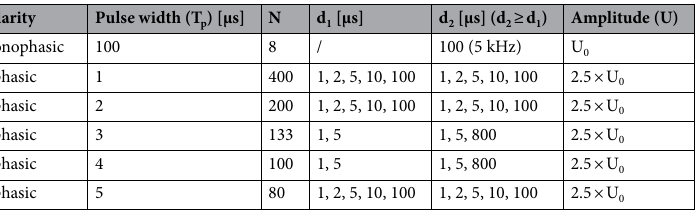
Table 1. Values of the pulse parameters for all pulse protocols included in the study. All biphasic pulse protocols have equal total on-time, i.e., N × 2Tp = 800 µs. Tp pulse width (equal for positive and negative phase); N number of pulses; d1 interphase delay; d2 interpulse